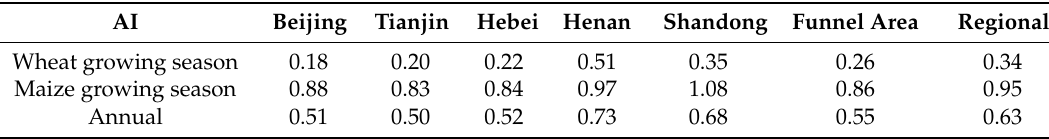
Figure 10. The spatial distribution of the long-term average aridity index on ( a ) the winter-wheat growing season; ( b ) the summer-maize growing season and ( c ) the annual basis. Table 9. The province-wide, funnel area, and regional statistics for the wheat, maize, and annual average aridity